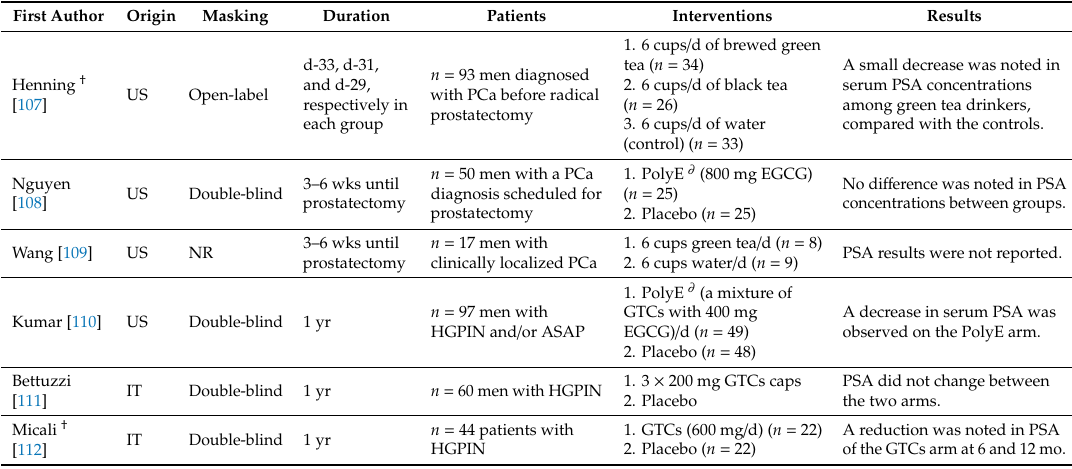
Table 5. RCTs examining the e ff ect of green tea and / or GTC supplementation on PSA concentrations among men with PCa or increased PCa